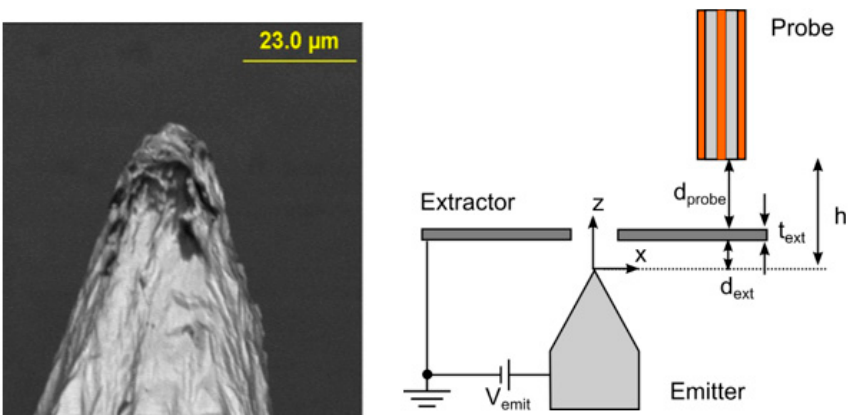
Figure 17. Left : Scanning electron microscope image of tungsten tip. Right : Probe geometry for spatially resolved emission current measurements.